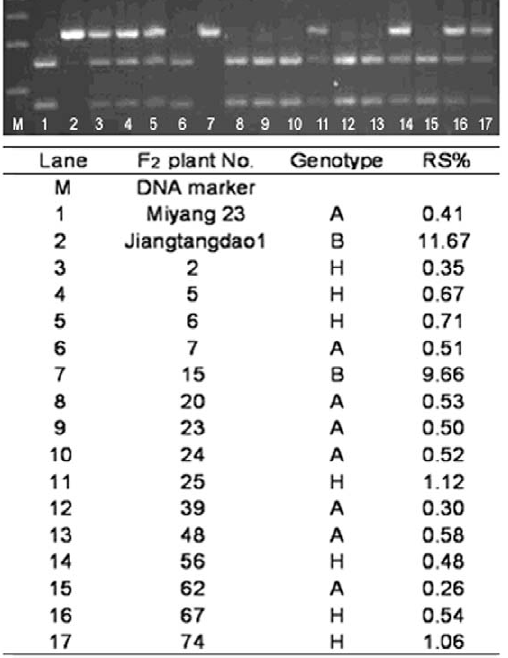
Table S1 The 86 genes and their putative functions in the region between InDel2 and InDel6 where sbe3-rs was located for rice resistant starch, predicted in Rice Genome Annotation Project (http://rice.plantbiology.